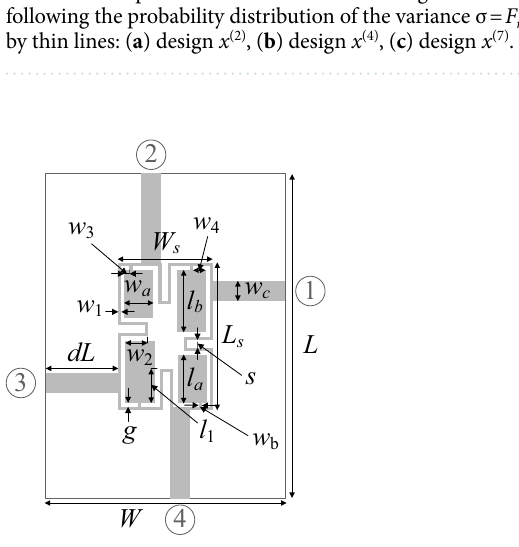
Figure 8. Geometry of the miniaturized microstrip branch-line coupler (BLC) 64